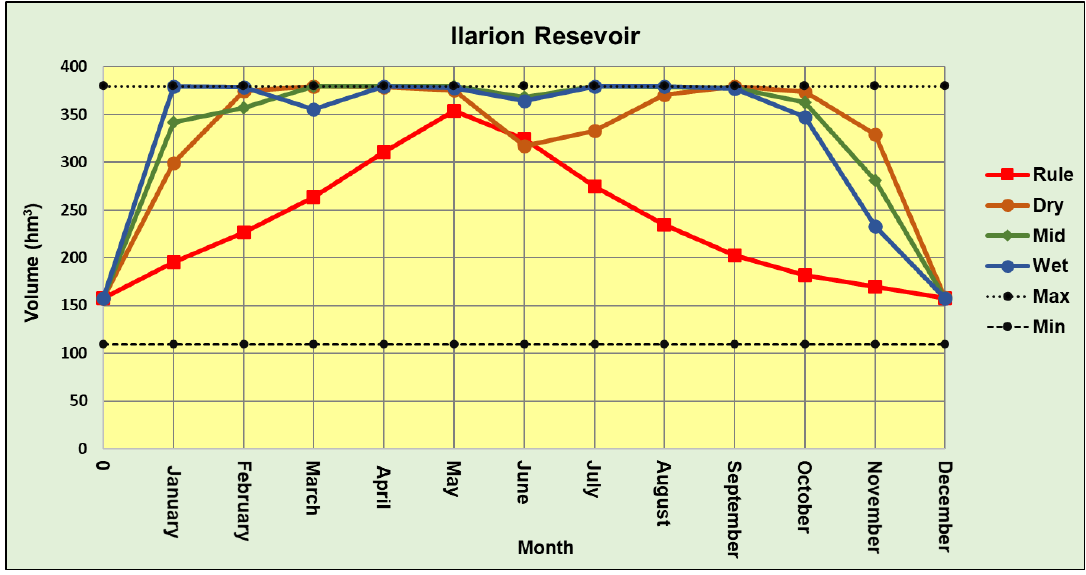
Figure 6. The optimal operation policies for the current state of water resources demand, ignoring